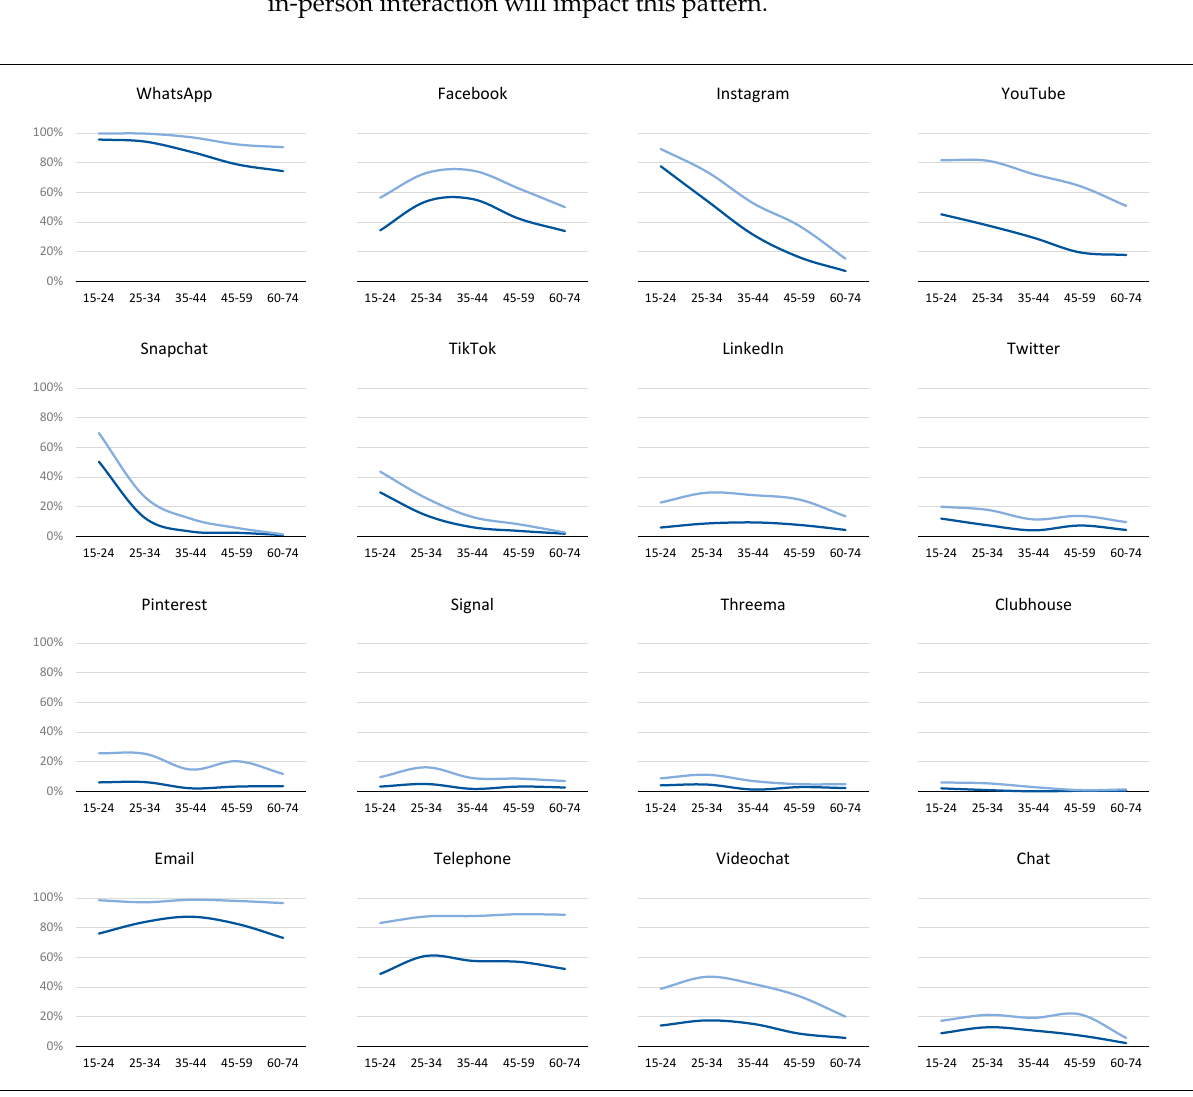
Figure 2. Daily (dark blue) and weekly (light blue) usage by age cohort. WhatsApp has broad and frequent use in Switzerland, with even 90% of older cus- tomers using the platform at least weekly. Facebook, in contrast, is exhibiting a particular age-cohort usage pattern. Younger and older users are not as invested as middle-aged customers. Because of this result, it is plausible that Facebook will encounter increasing challenges in the Swiss market. Instagram is a platform clearly preferred by younger gen- erations, as are Snapchat and TikTok. YouTube exhibits a similar pattern, albeit with the highest proportion of weekly users among all platforms. Several other platforms, espe- cially some newer and promising ones at the time of the survey, such as Signal, Threema, and Clubhouse, have low usage across all age groups. Email is widely used, but daily usage among younger customers drops off, signaling that the continued preference for